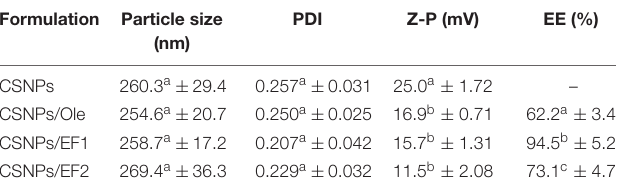
Yield in EF2 (mg/g) (mg/g) TABLE 3 | The particle size, polydispersity index (PDI), zeta potential (Z-P), and encapsulation efficiency (EE%).